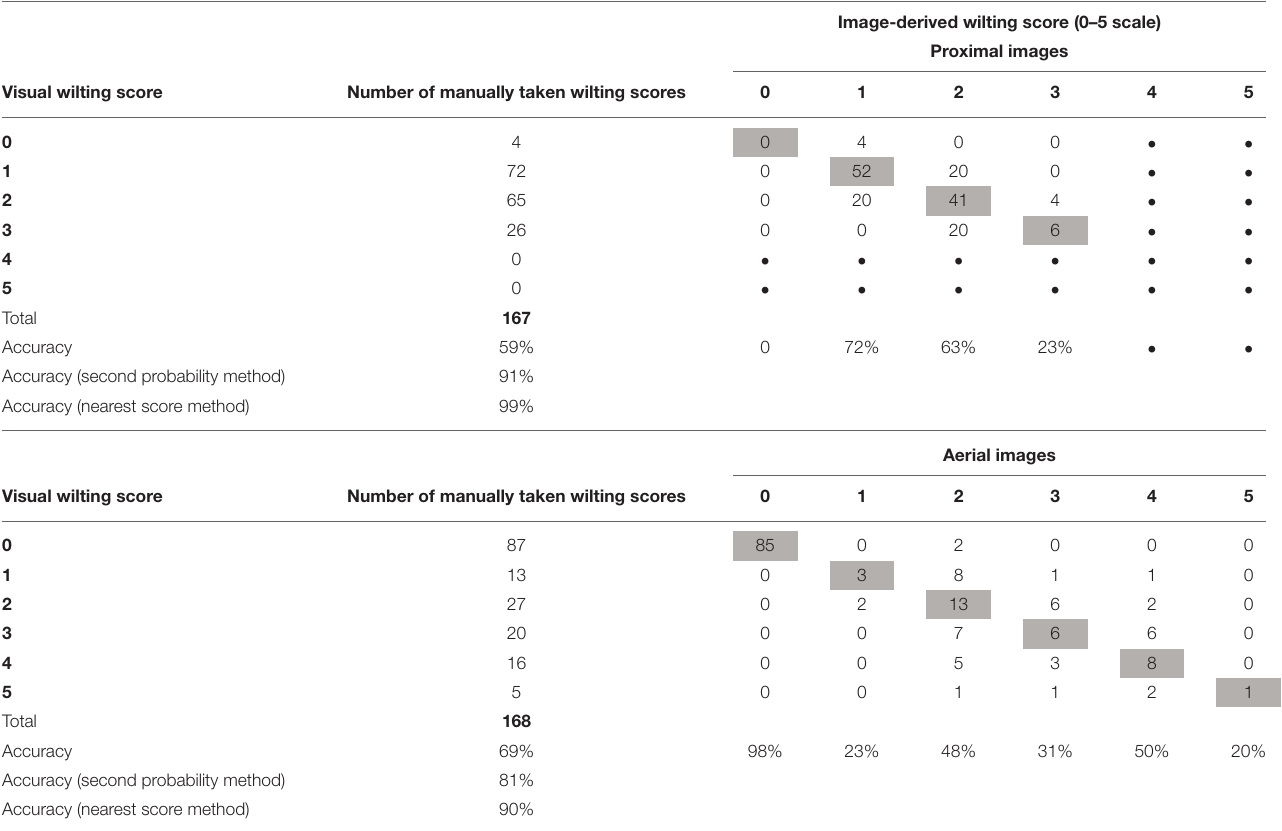
TABLE 5 | Wilting accuracy matrix with the number of manually taken wilting scores (2018) on a visual scale at the left and outside the table and the count of image-derived wilting scores in the table.